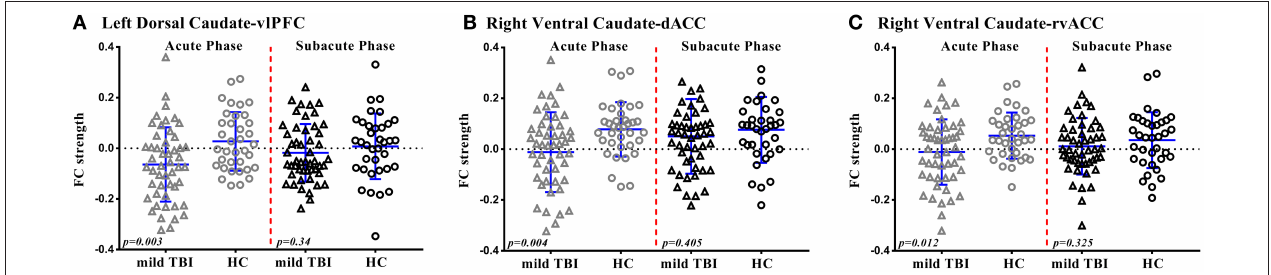
FIGURE 4 | Scatterplots of Functional Connectivity (FC) strength of significant regions are displayed for mild TBI (open triangles) and HC (open circles) at acute phase and subacute phase. Each symbol represents a single individual’s FC strength. The I bars indicate the means and standard deviation. The p -values were obtained from group mean difference. (A) Left dorsal caudate-vlPFC functional connectivity. (B) Right ventral caudate-dACC functional connectivity. (C) Right ventral caudate-rvACC functional